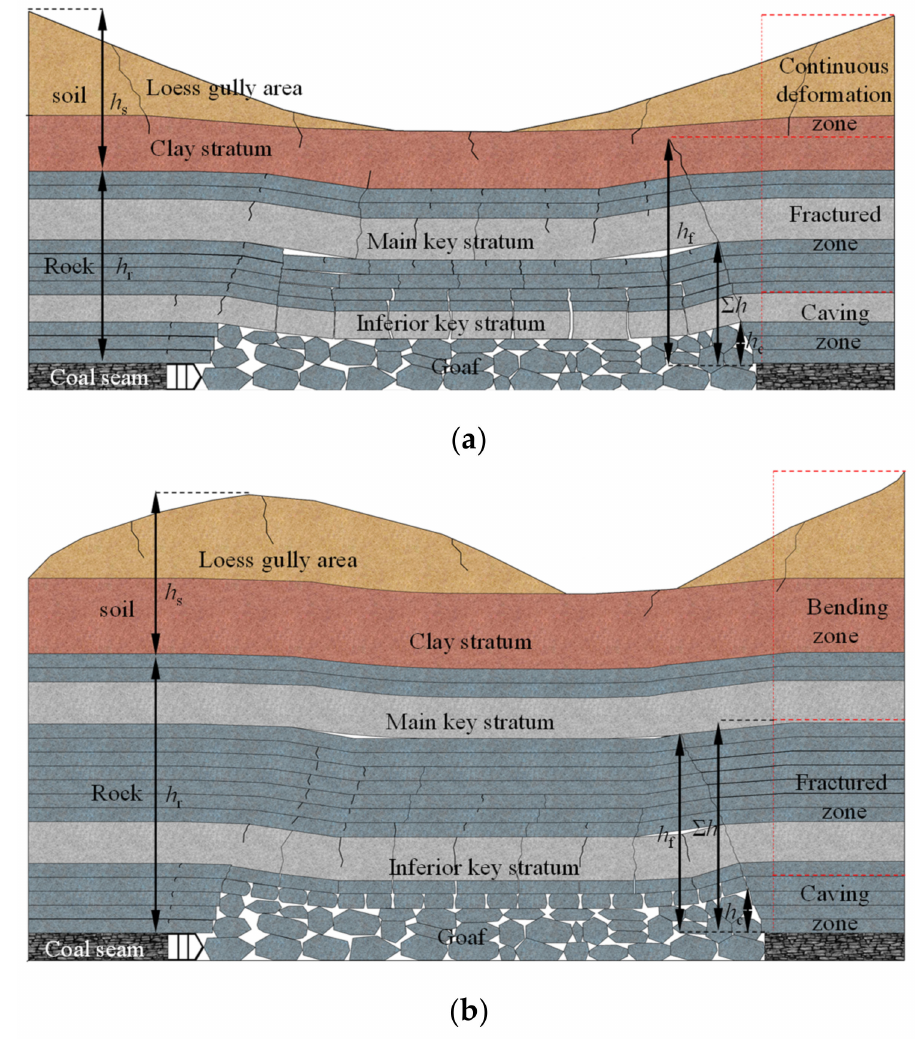
Figure 4. Migration principles of overlying rock under continuous deformation: ( a ) the main key stratum is located in the curved subsidence zone; and ( b ) the main key stratum is located in the bending zone.